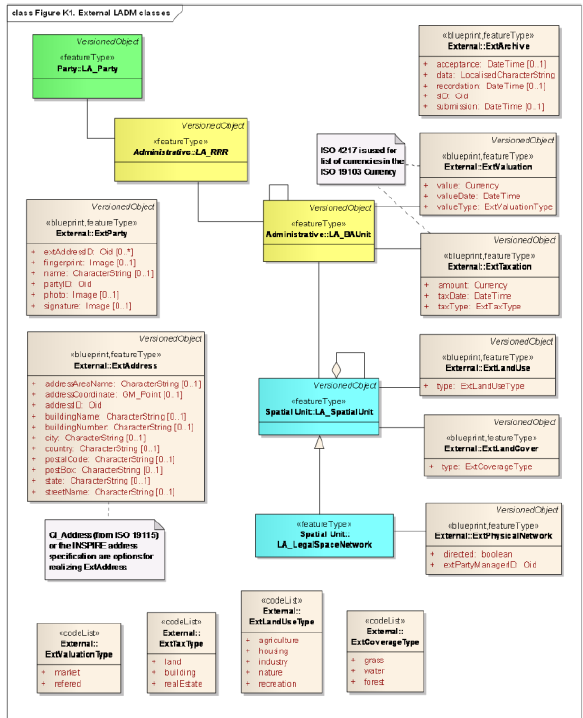
Figure 5: Core class LADM (in colour and) and LADM external classes (with ‘Ext’ prefix), taken from ISO